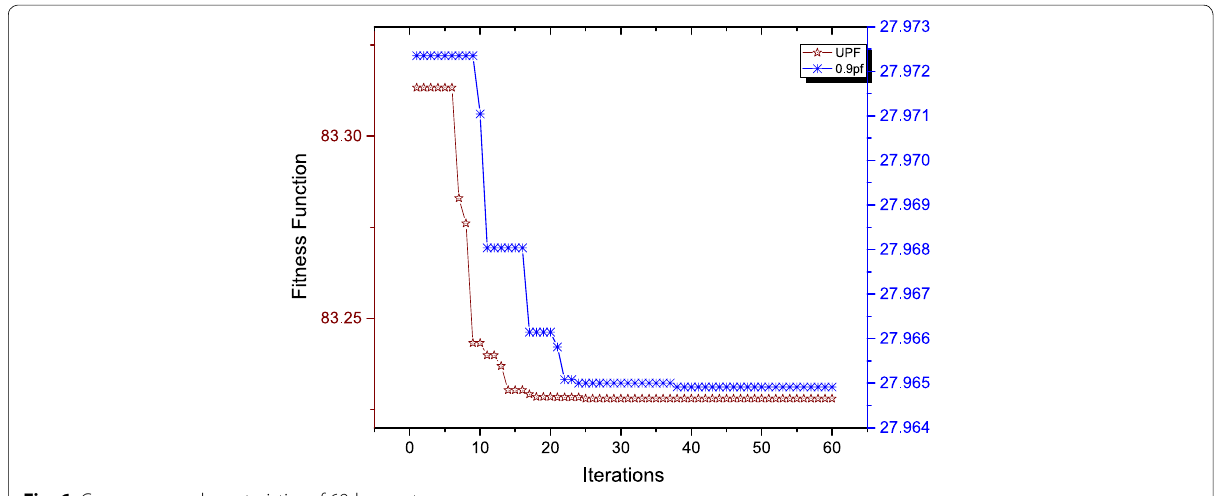
Fig. 6 Convergence characteristics of 69-bus system